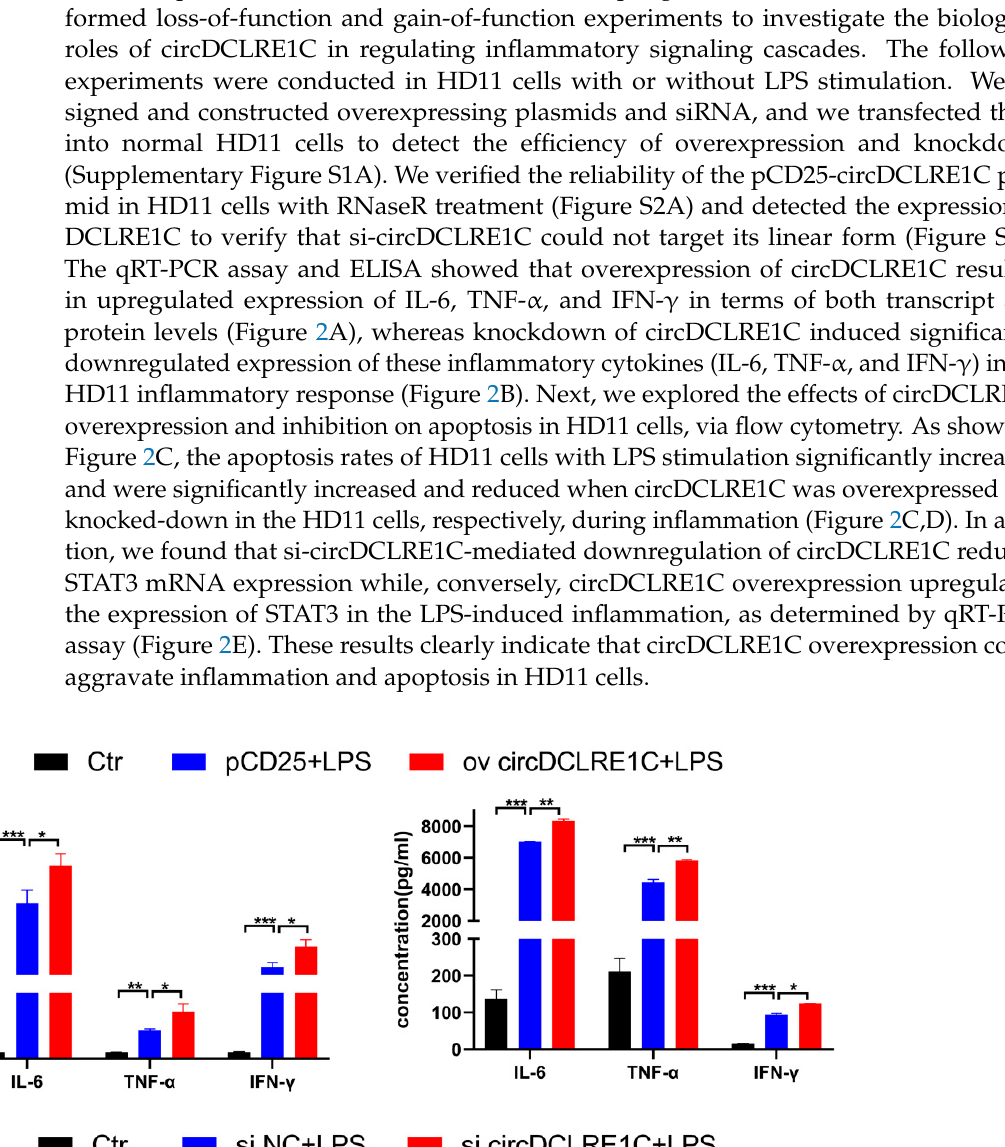
Figure 2. CircDCLRE1C aggravated LPS-induced inflammation and apoptosis in HD11 cells: ( A , B ) ELISA and qRT-PCR assay showing the expression levels of IL-6, TNF- α , and IFN- γ in HD11 cells with circDCLRE1C knockdown or overexpression. ( C , D ) Cell apoptosis measured with Annexin V– FITC/PI apoptosis detection kit via flow cytometry assay. ( E ) The mRNA levels of STAT3 in HD11 cells with circDCLRE1C overexpression and knockdown. Data are presented as means ± SD ( n = 3 biologically independent samples). * p < 0.05; ** p < 0.01; *** p < 0.001 (Student’s t -test). 2.3. CircDCLRE1C Could Serve as a Sponge for miR-214b-3p Regulating STAT3 mRNA Expression In order to determine the mechanism of circDCLRE1C-associated regulation of the progression of macrophage inflammation, we used online software for miRNA target pre- diction (https://bibiserv.cebitec.uni-bielefeld.de/, accessed on 1 December 2021)) based on